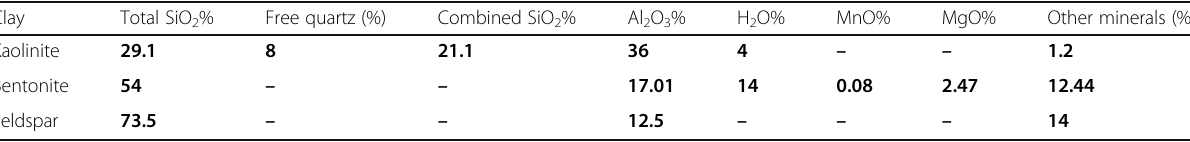
Table 1 Chemical composition of the used clays (Yahaya et al. 2017; Hassan and Abdel-Khalek 1998; Boulos et al. 2015) Clay Total SiO 2 % Free quartz (%) Combined SiO 2 % Al 2 O 3 % H 2 O% MnO% MgO% Other minerals (%) Kaolinite 29.1 8 21.1 Bentonite 54 – Feldspar